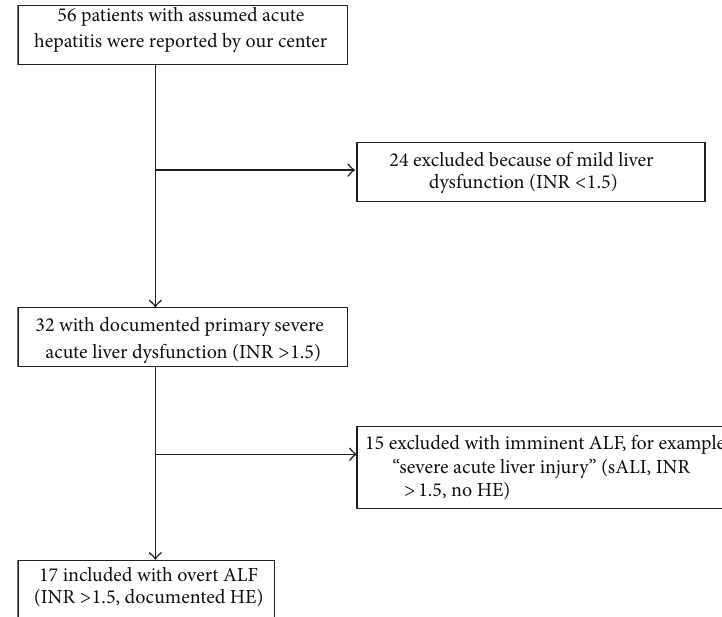
Figure 1: Enrollment of study patients.